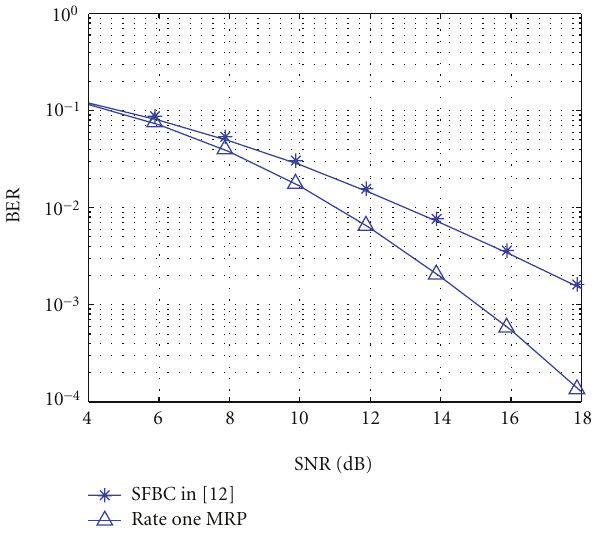
Figure 6: Performance of the rate one MRP and the SFBC in [12] for the MIMO-OFDM system with N t = 2, N r = 1, N c = 512, and δ = 128 in the propagation scenario with uniform PDP of two